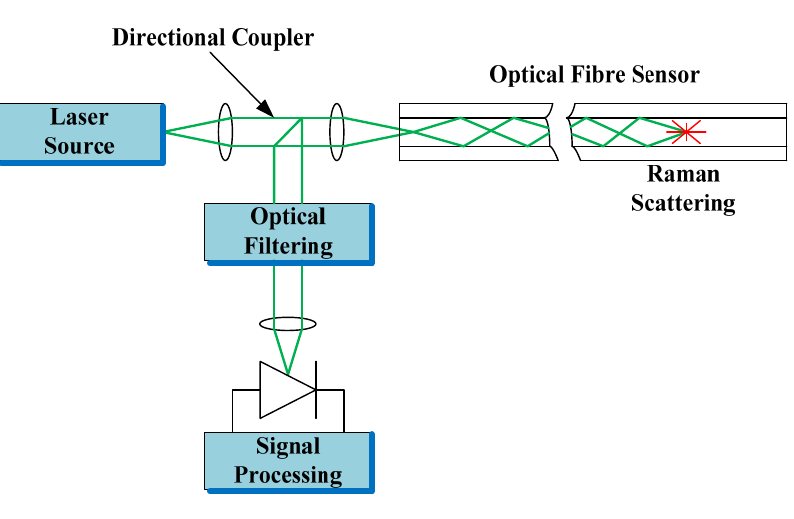
Figure 1. Principle of distributed temperature sensing